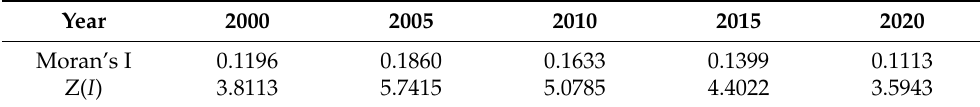
Table 3. Global Moran’s I of land-use carbon emissions in the Yellow River Basin from 2000 to 2020.